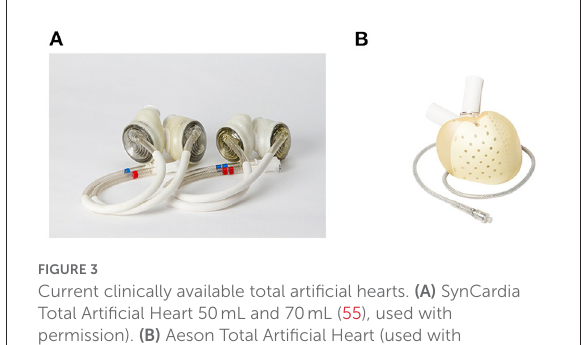
FIGURE3 Current clinically available total artificial hearts. (A) SynCardia Total Artificial Heart 50mL and 70mL (55), used with permission). (B) Aeson Total Artificial Heart (used with permission by Carmat